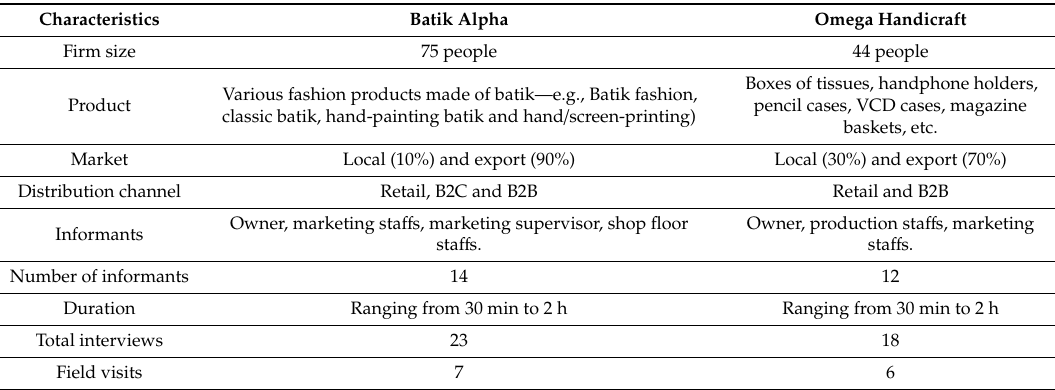
Table 1. Company Profile of Case